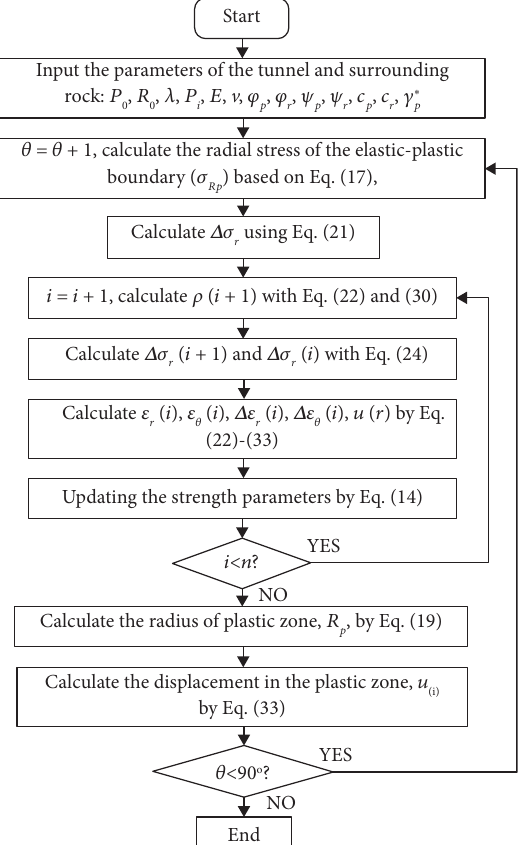
Figure 4: Flowchart for the sequence of calculations.